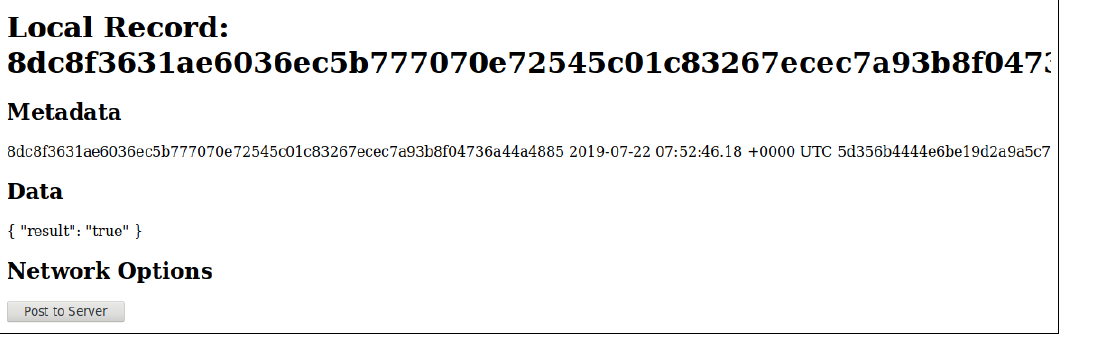
Figure 9. Result record return by the hypertension service in response to the patient’s request.